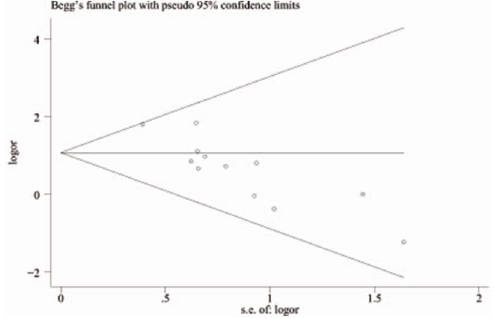
Figure 5. Begg’s funnel plot of publication bias test of severe preeclampsia associated with the prothrombin G20210A polymorphism. LogOR means nature logarithm of OR (odds ratio). Horizontal line means the summary estimate, while the sloping lines mean the expected 95% confidence interval.